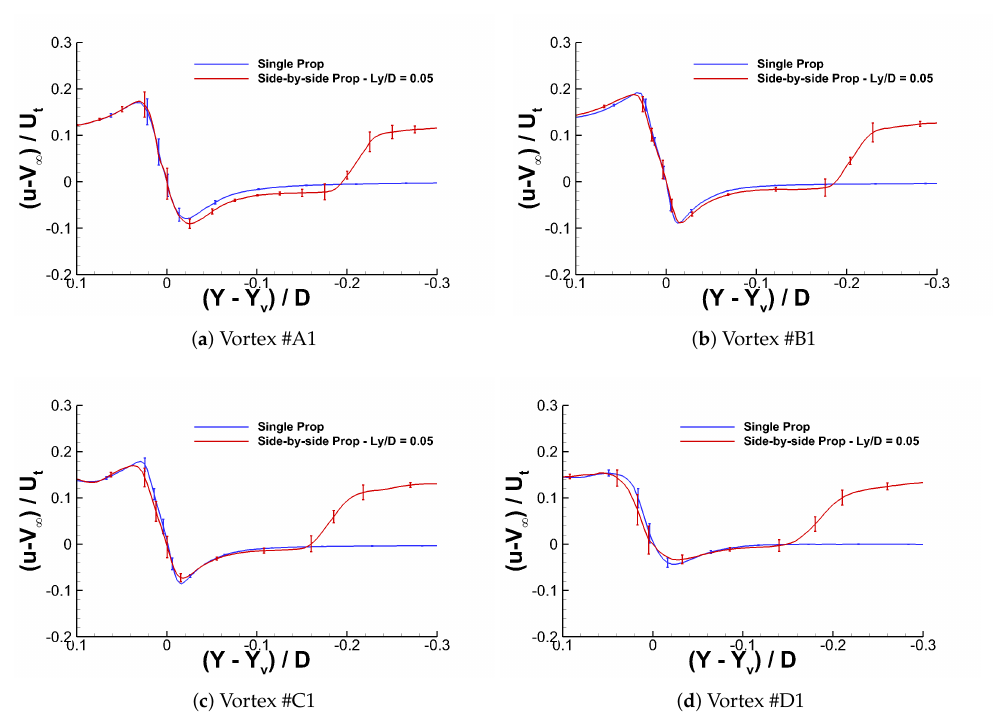
Figure 12. Comparison of the phase-averaged non-dimensional freestream velocity component profiles u extracted in correspondence with the tip vortex core locations ( X v , Y v ) for blade azimuthal angle ψ = 90 ◦ and advance ratio J = 0.4 , Re D = 1.96 × 10 6 , and M t =